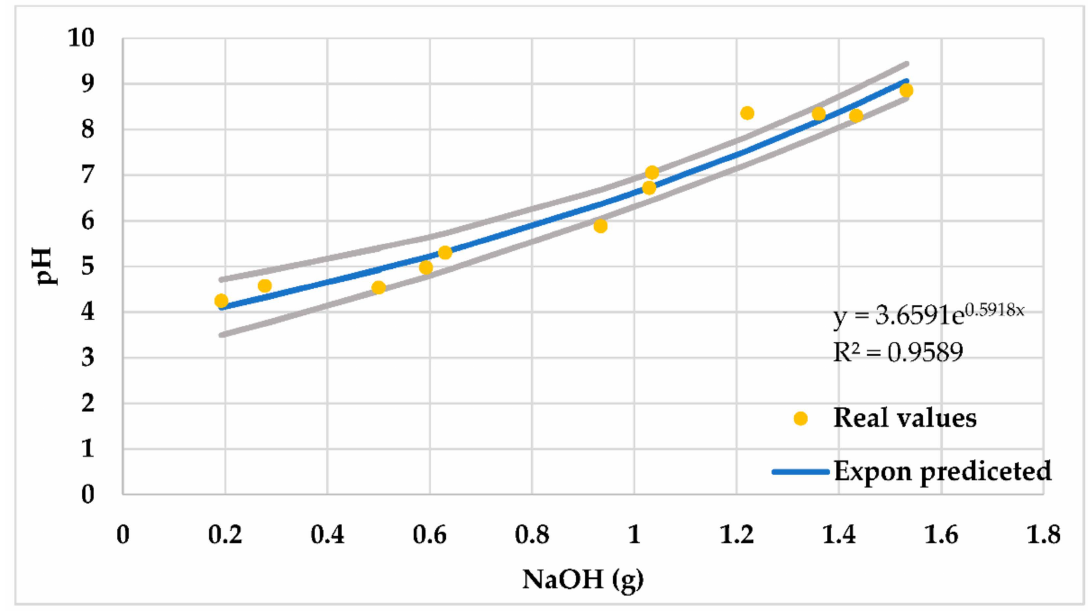
Figure 4. Effect of adding NaOH on chelating agent pH level when 10 vol% added to SW.